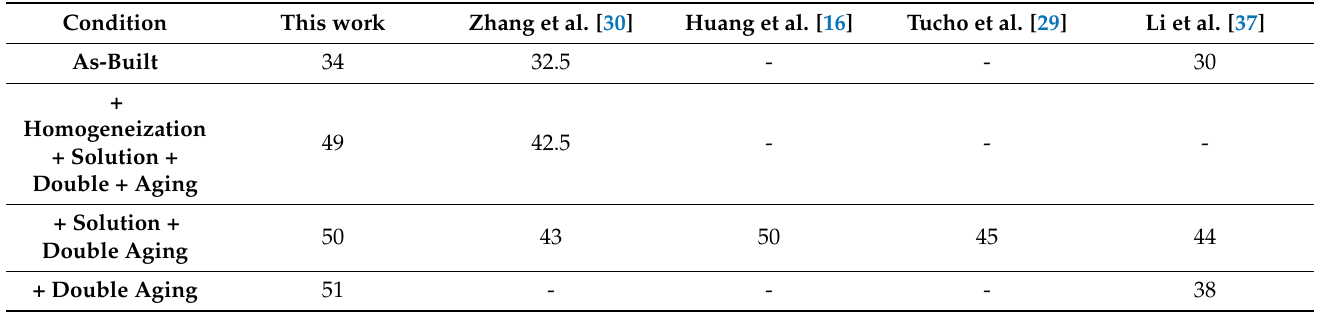
SLM Y -axis samples) compared to other Table 8. Summary of hardness values (HRC) obtained in this work (mean values converted from